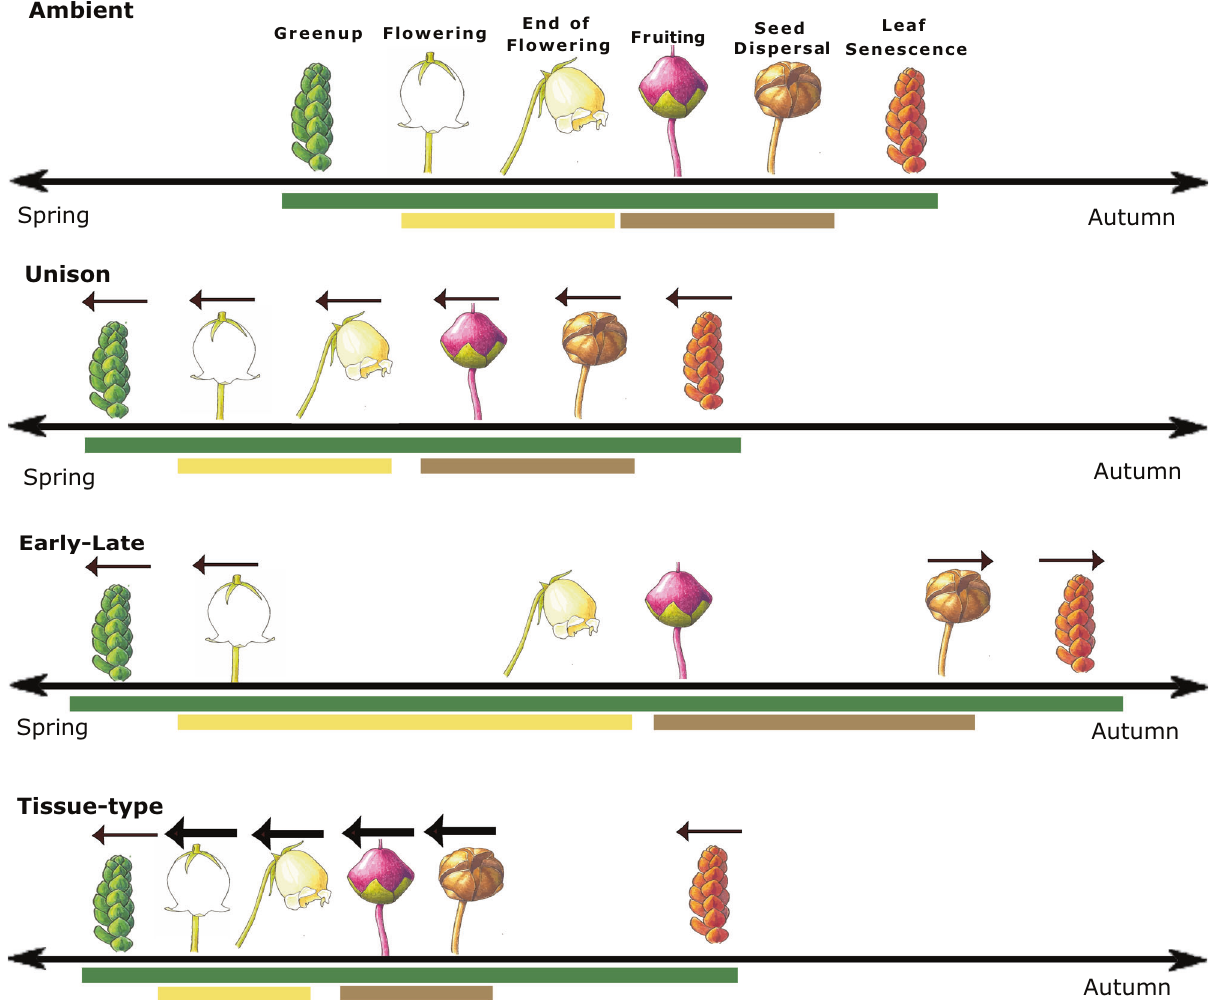
Fig. 1 Potential scenarios of plant phenology responses to warming. Phenophases are represented by images, and their timing re fl ected by their relative position on the line from spring to autumn. The arrows above images show the direction and magnitude (arrow thickness) of changes in timing for each phenophase in response to warming. Green, yellow, and brown horizontal bars re fl ect the length (duration) of the growth, fl owering, and fruiting periods, respectively. Ambient signi fi es no warming (i.e., control). Unison response scenario: all phenophases shift in the same direction (earlier) by an equal magnitude. The timing of phenology is shifted but there is no change in the duration of phenoperiods. Early-late response scenario: early (spring) and late (autumn) season phenophases shift in different directions (earlier, later) with the same magnitude. The timing of phenology is shifted and the duration of growth, fl owering, and fruiting periods are lengthened. Tissue-type response scenario: all phenophases shift in the same direction (earlier) but reproductive phenophases shift by a greater magnitude than vegetative phenophases. The timing of phenology is shifted and the duration of the fl owering and fruiting periods are shortened. The fi rst response scenario describes an example of phenology having fi xed periodicity where all phenophases shift in concert in response to warming. The second and third scenarios describe examples of distinct responses to warming between early vs. late season or vegetative vs. reproductive phenology, which can result in either a lengthening or shortening of vegetative and/or reproductive periods. This is not an exhaustive list but rather three hypothetical scenarios out